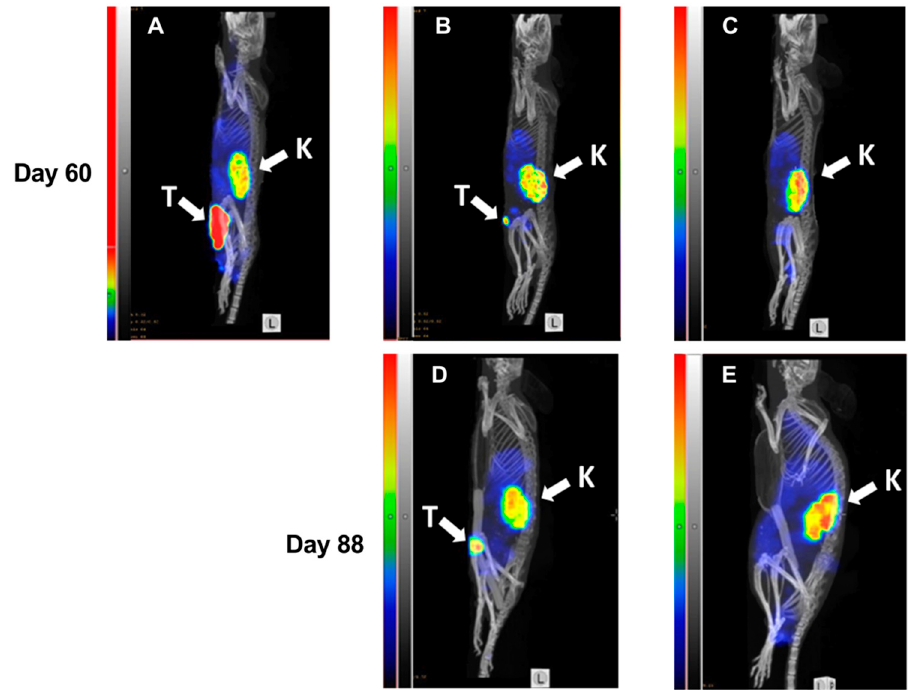
Figure 7. MicroSPECT/CT imaging of HER2-expression in BALB/c nu/nu mice bearing SKOV3 xenografts. Maximum Intensity Projections, sagittal view. Imaging was performed at days 60 ( A – C ) and 88 ( D , E ) of the experimental therapy. A mouse from the PBS-treated control group with a large necrotic tumor ( A ). A mouse with a small tumor from the group treated with Z HER2:2891 -ABD-E 3 -mcDM1 (15.1 mg/kg) at day 60 ( B ) and at day 88 ( D ). A mouse without any visible tumor from the group treated with Z HER2:2891 -ABD-E 3 -mcDM1 (10.3 mg/kg) at day 60 ( C ) and at day 88 ( E ). The relative scale in ( A ) was adjusted to the same level of activity in kidneys for ( B – E ).